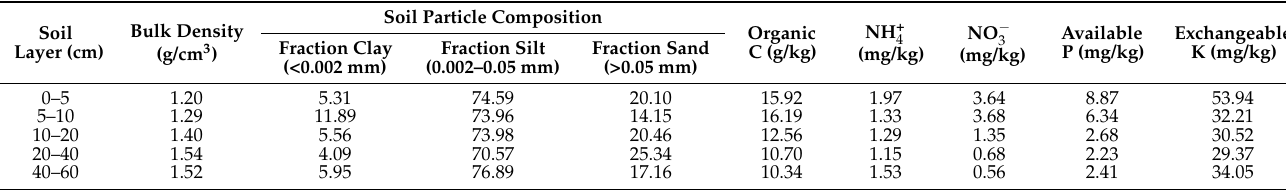
Table 1. Basic physicochemical characteristics of each soil layer at the study site.